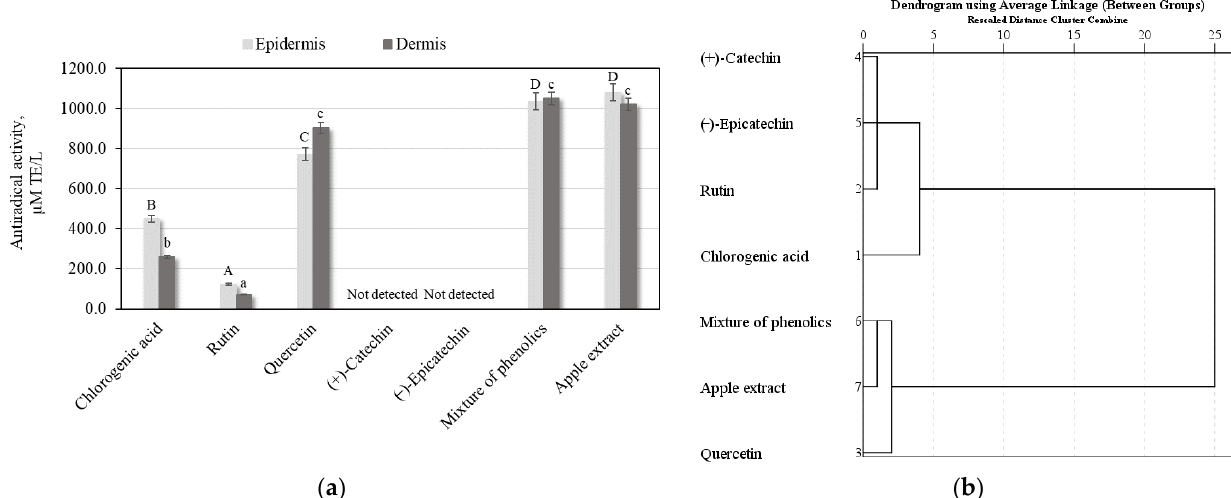
Figure 5. Results of antioxidant activity studies: ( a ) Antiradical activities of human skin extracts after applying the pure individual phenolics, mixture of phenolic compounds, and apple extract; ( b ) The dendrogram illustrates variation in the antioxidant activities of human skin extracts after applying experimental samples. Uppercase letters indicate a statistically significant difference in the antiradical activities of human skin epidermis extracts; lowercase letters indicate a statistically significant difference in the antiradical activities of human skin dermis extracts ( p < 0.05).